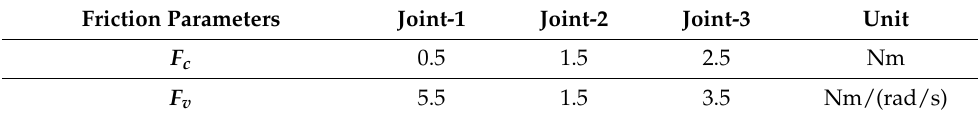
Table 2. Coulomb plus viscous friction model parameters.